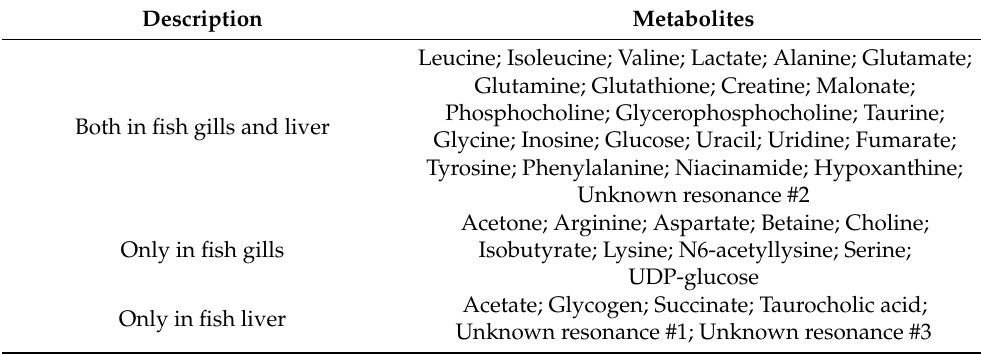
Table 2. Metabolite comparison between the gills and liver of golden grey mullet ( C. auratus ) that were sampled from the reference area S ã o Jacinto (SJ), northwest coast of Portugal.